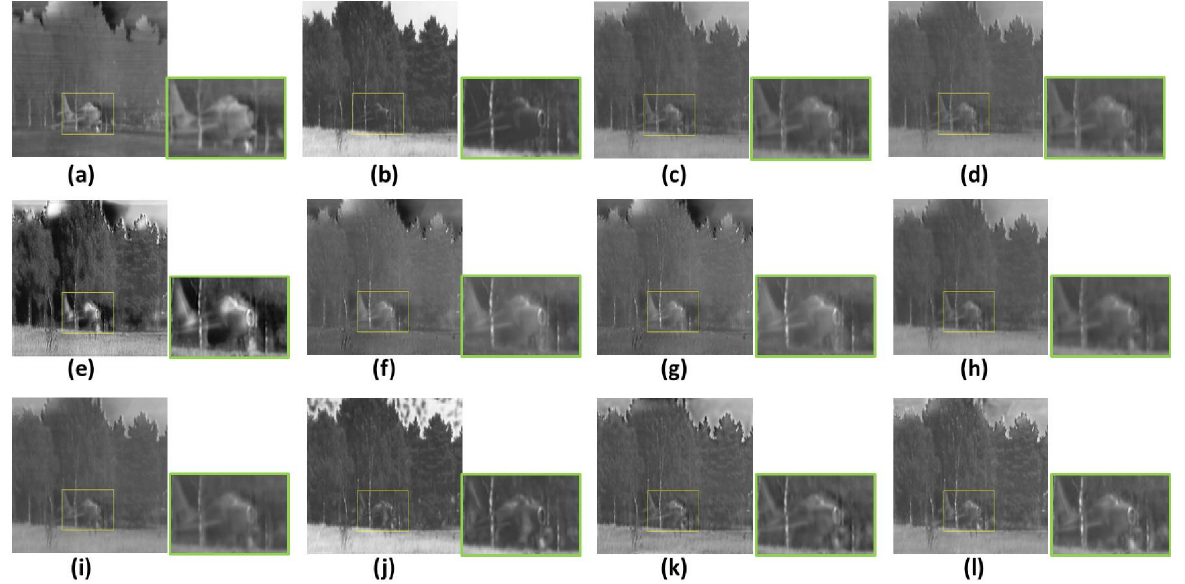
Figure 5. Visual IF results of different methods on airplane in trees: ( a ) IR image, ( b ) VIS image,